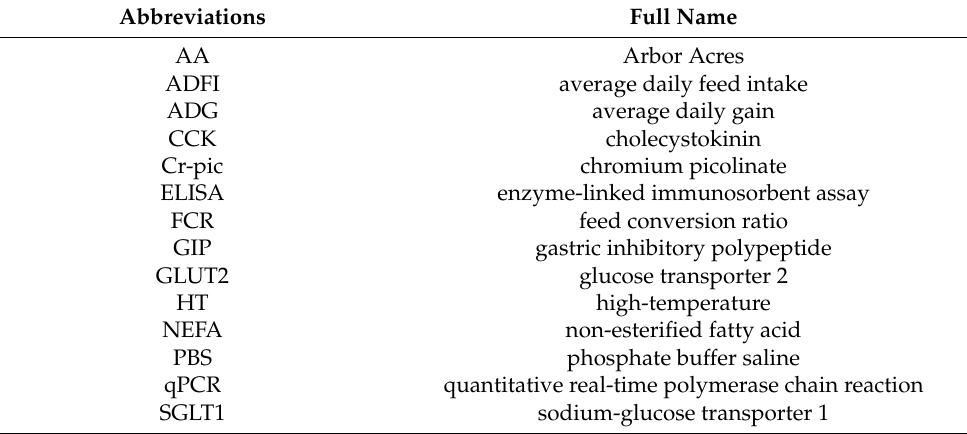
Table 1. List of abbreviations in this